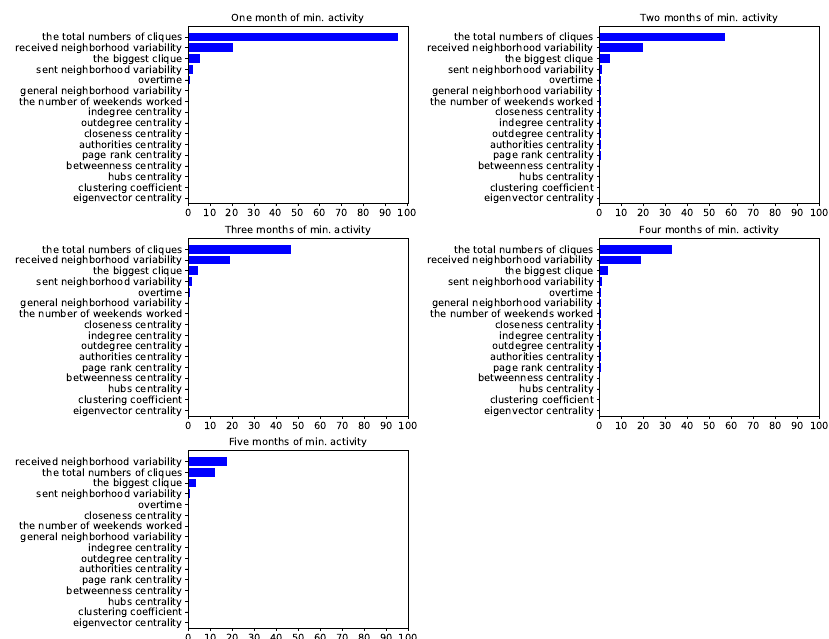
Figure A5. Features importance (based on univariate feature selection method which uses chi-squared test) for the Neural Network and SVM which use the full set of features for the manufacturing company dataset with two levels of the hierarchy.